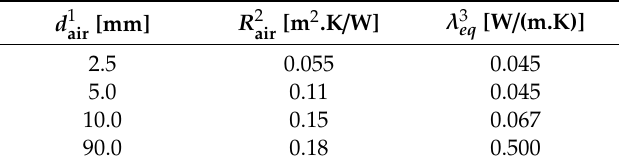
Table 7. Thermal resistance and solid-equivalent thermal conductivity of air